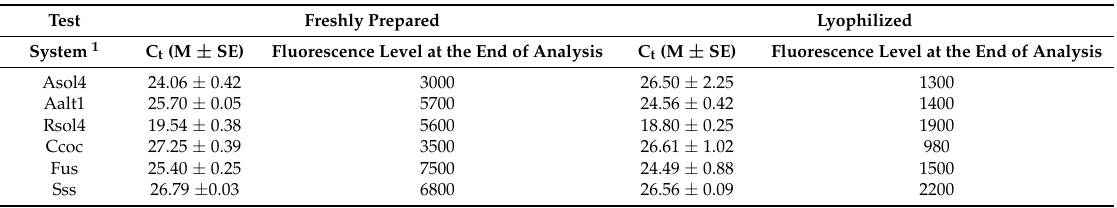
Table 6. Comparison of working efficiency of freshly prepared and lyophilized microarrays for detection and identification of fungal pathogens of potato.